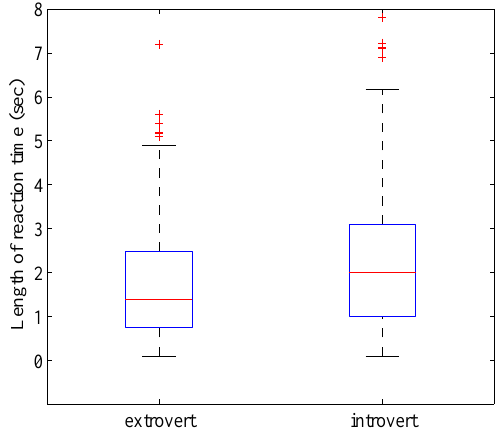
Fig. 4. Reaction time (Source: findings from the prelimi- nary experiments for this